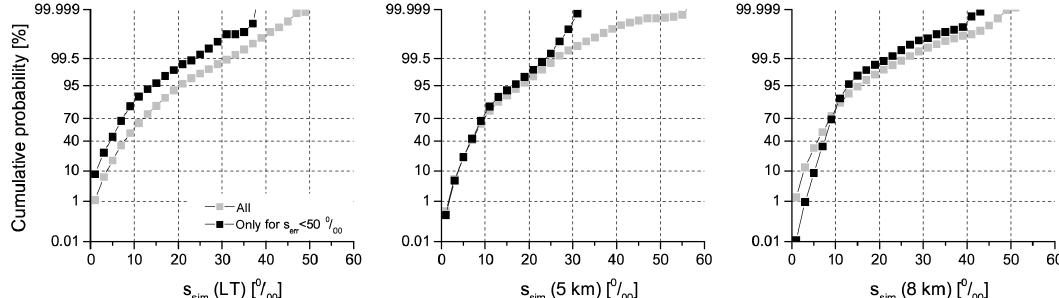
Figure 8. Cumulative occurrences of the s sim value obtained for 1500–2000m above surface, 5 and 8kma.s.l. (from the left to the right, respectively). The calculations of S sim are made according to Eq. (8). The grey dots are for all data and the black dots only for situations with good sensitivity s err ≤